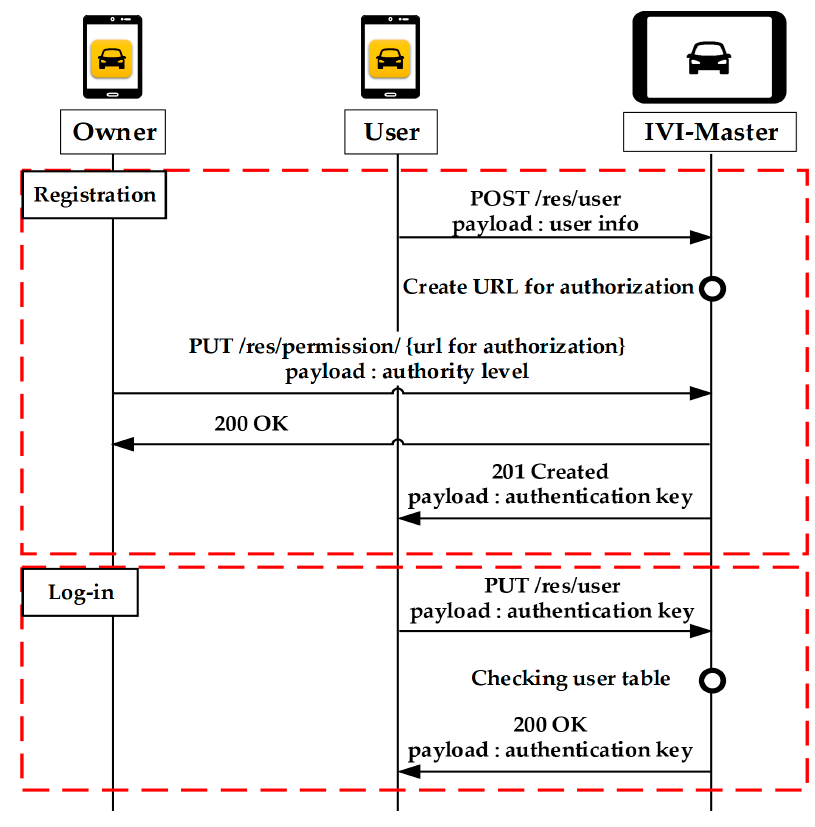
Figure 7. Registration of user.